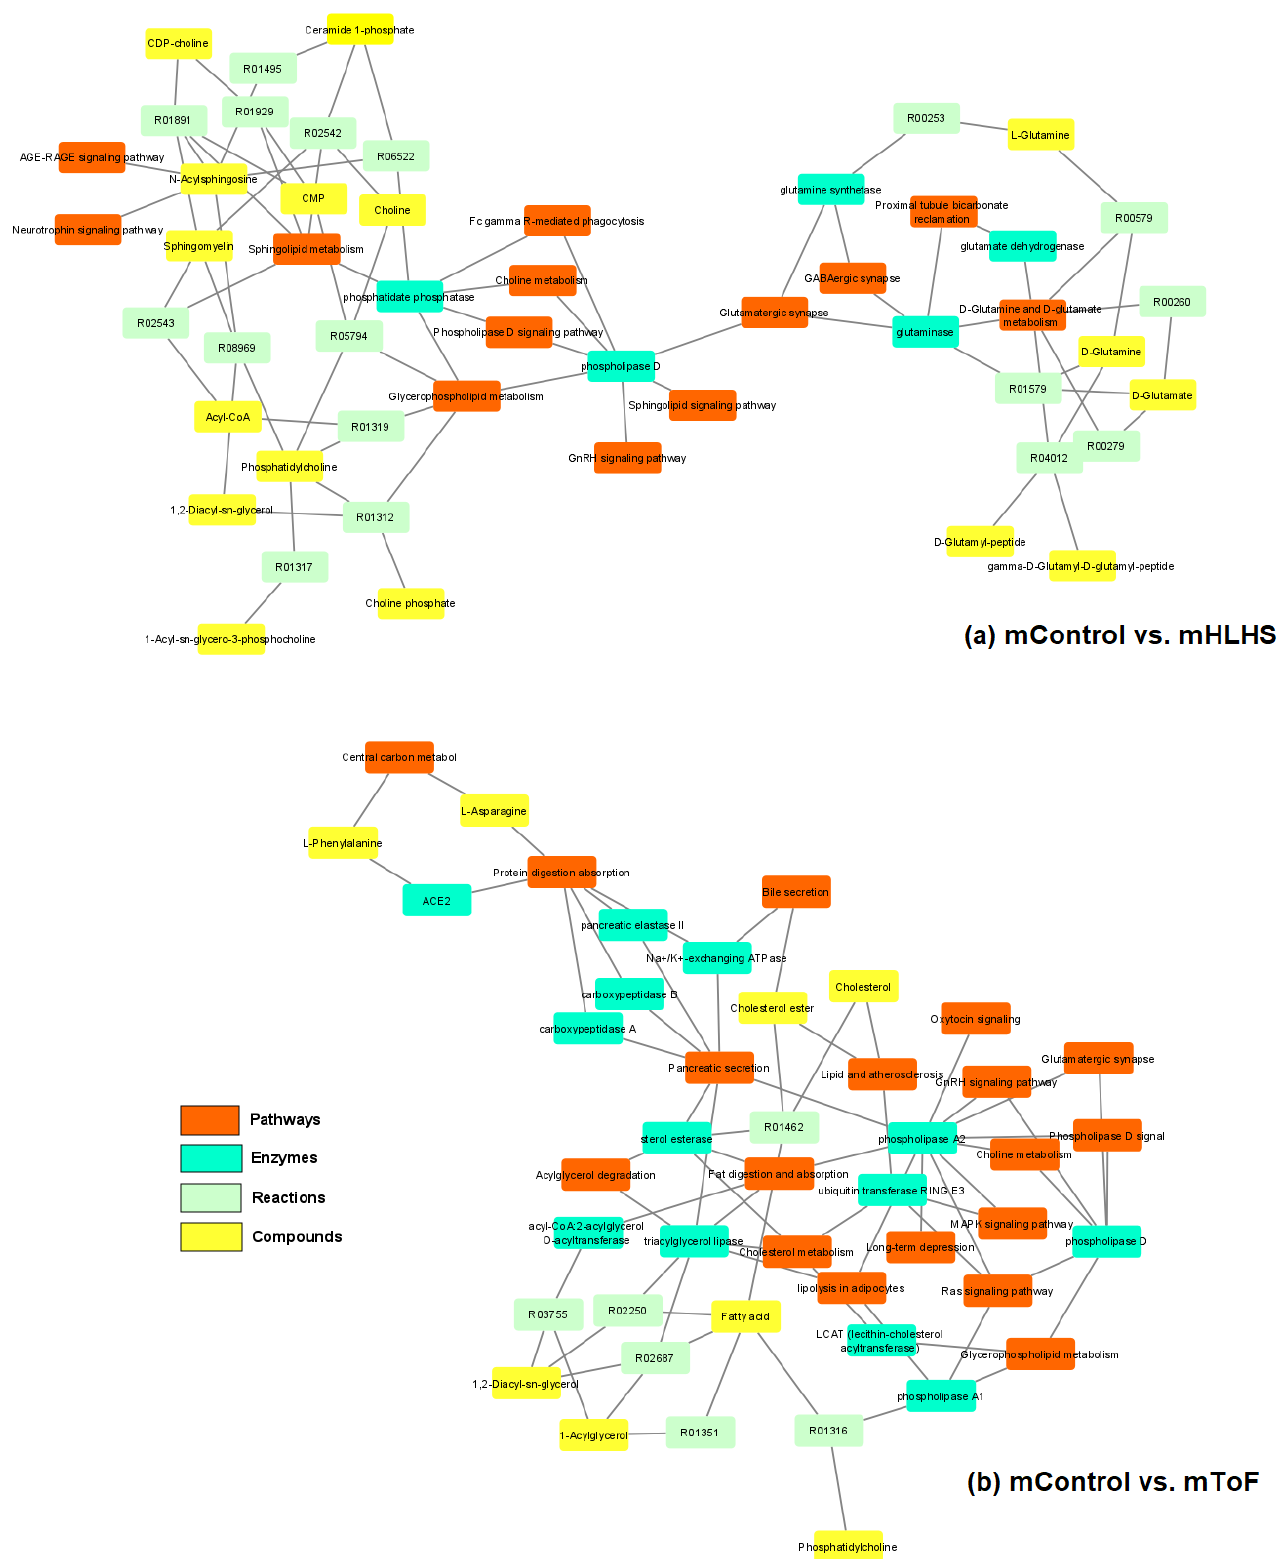
Figure 7. Metabolic pathways associated with ( a ) mHLHS and ( b ) mToF pregnancies when comparing with normal controls. The depicted networks revealed pathways (orange nodes), enzymes (light blue nodes), reactions (light green nodes), and metabolites (yellow nodes) that were involved in the pathways affected ( p <